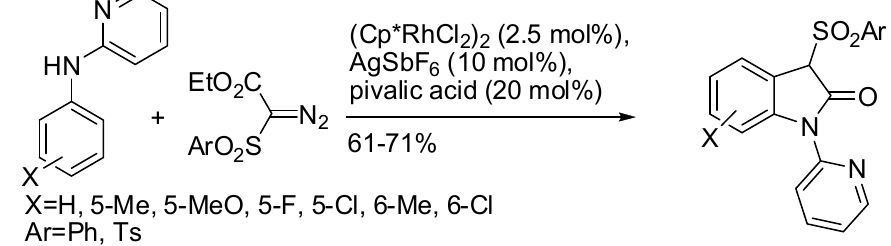
Scheme 53. Oxindole derivatives from pyridyl-substituted anilines and diazo compounds.